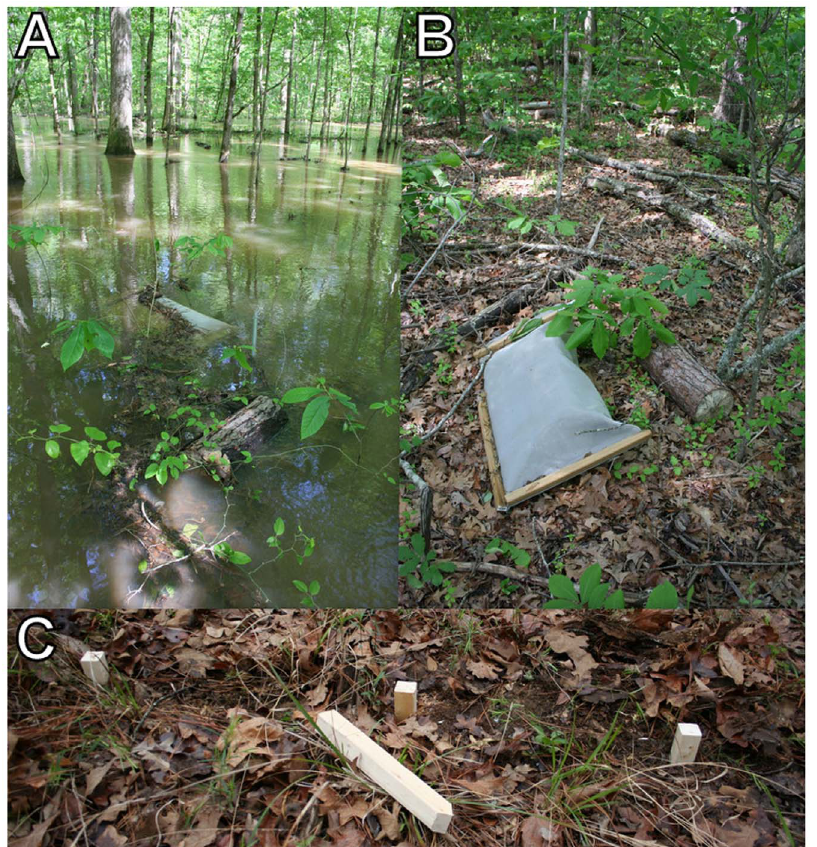
Figure 2. A pair of protected and unprotected bolts at a flooded (A) and unflooded (B) location in northeastern Mississippi, U.S.A. Wooden stakes were used to compare Reticulitermes activity between forest types (C).